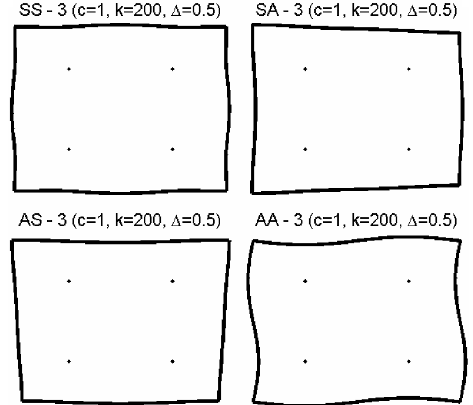
Fig. 7. Mode shapes (3 rd mode, Case 2, c = 1, ∆ =